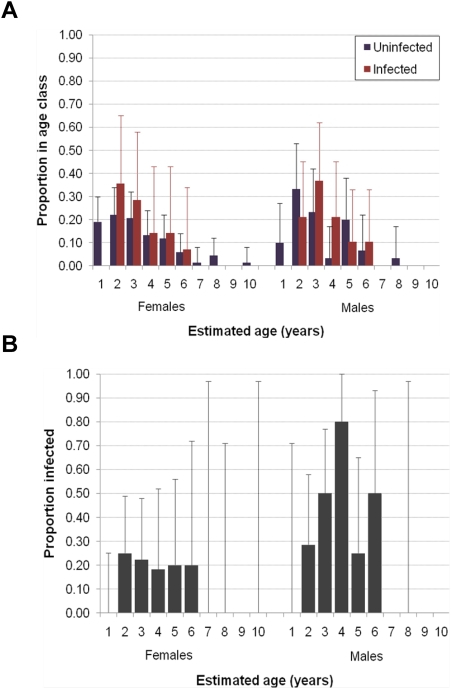
Demographic distribution of prion infection among Table Mesa mule deer.(A) Age distributions of prion-infected male and female deer as compared to age distributions of apparently uninfected female and male deer sampled, expressed as the proportion of the total number of deer in respective sex×infection status group that occurred in each age class. (One-year-old deer likely were underrepresented in our sample because we avoided capturing them for use in survival comparisons.) (B) Age class-specific estimates of prion infection prevalence for sampled female and male deer. Bars are +95% binomial confidence intervals of estimated proportions.